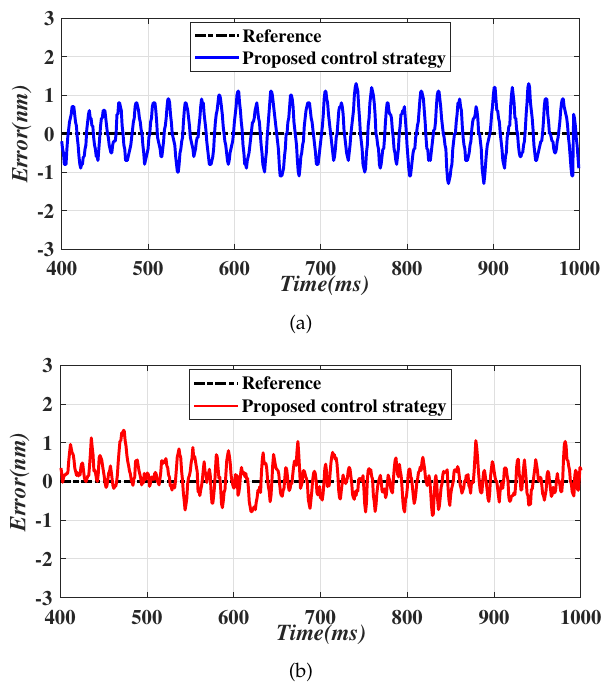
Figure 11. Tracking error under the proposed composite control strategy. ( a ) Reference = 20 nm. ( b ) Reference = 50